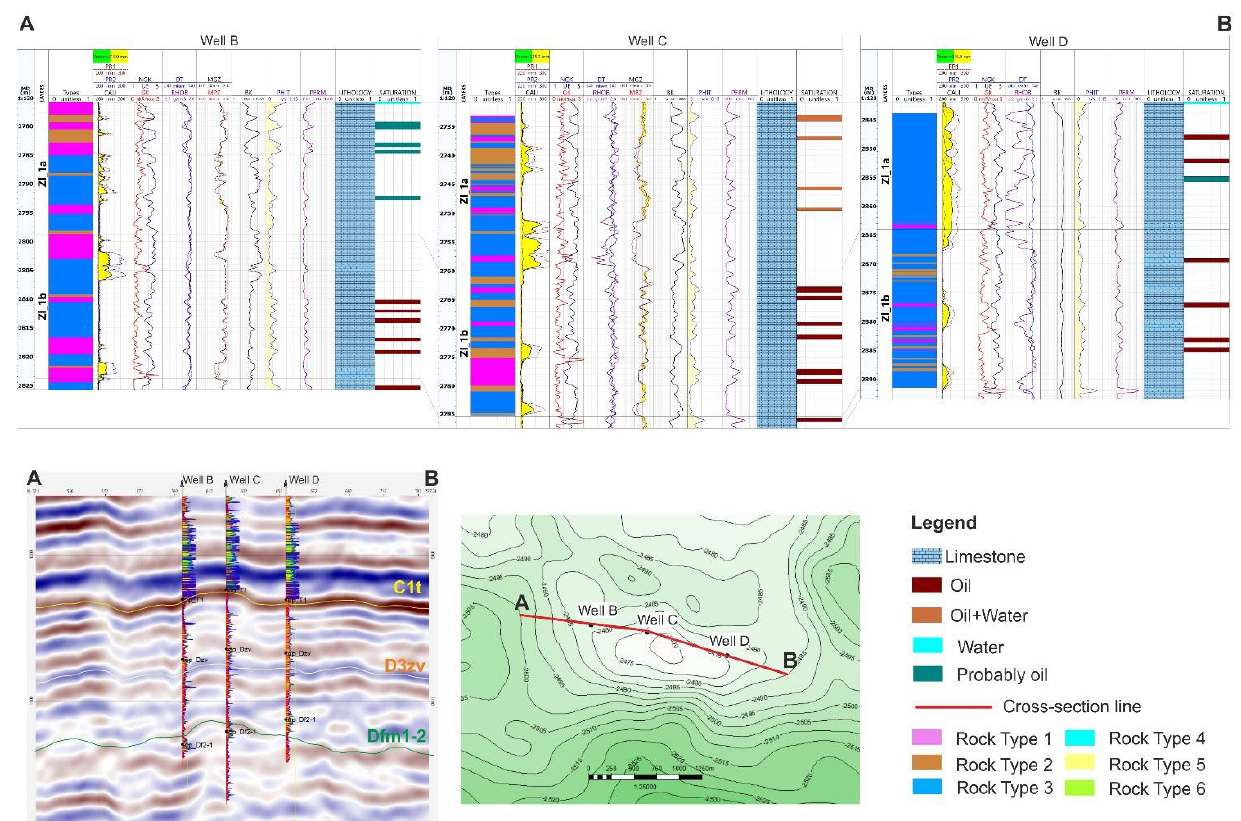
Figure 11. Final correlation of the wells based on the proposed rock-typing approach. A,B is cross section line through well B, C, D. For well B, rock types were assigned using the full dataset (FMI, petrography, etc.). For wells C and D, where only conventional logs and core were presented, rock types were created by dint of the developed Python script. The script is based on the Rock Type Catalogue.